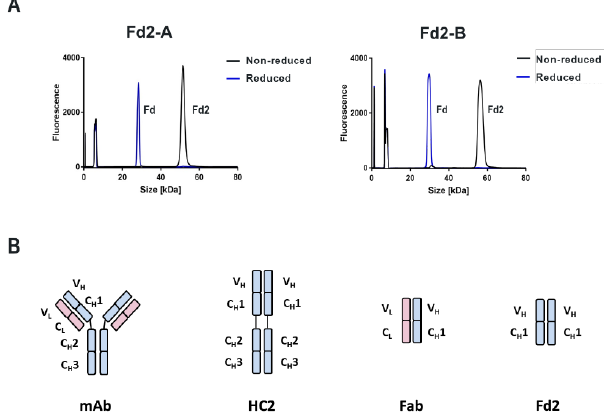
Figure 2. ( A ) Overlaid NR-cSDS and Red-cSDS profiles for both Fd2 forms Fd2-A and Fd2-B. The intact Fd2 dimer is reducible into monomeric Fd domains by DTT and appears as a Fd monomer by Red-cSDS. Peaks below approximately 10 KDa are system-related peaks and include the internal MW standard. ( B ) Diagrams representing a mAb, HC2, Fab, and Fd2. The HC is colored light blue and the light chain is light red. Each individual variable and constant domain composing the HC and LC are labeled. Intermolecular disulfides are not shown but exist in the hinge region and between C L and C H 1 as well as between the C H 1 domains in the HC-only structures. HC-only Fd2 domains (V H + C H 1) are shown here to be associated.